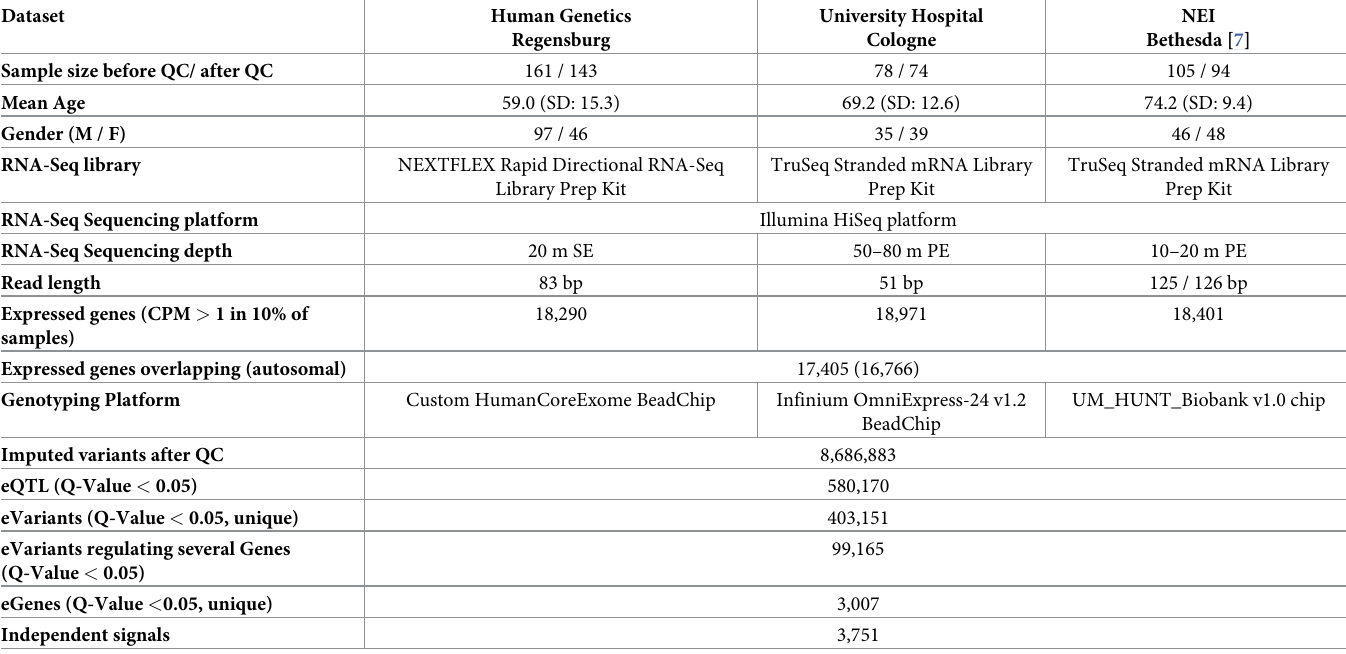
Table 1. Study and sample